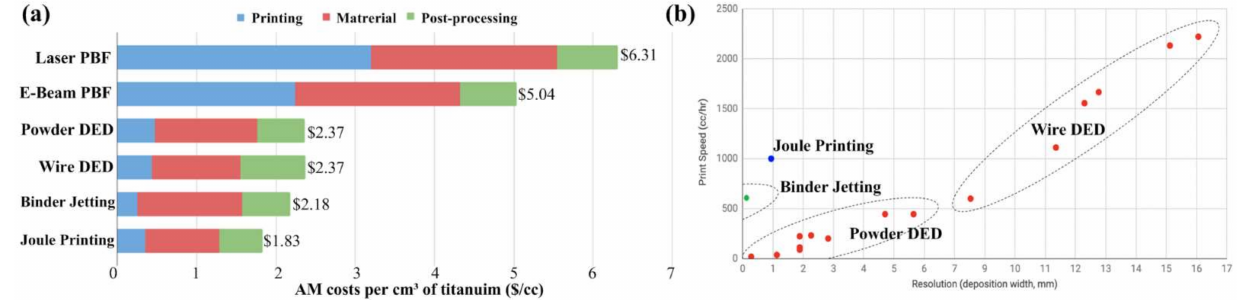
Figure 6. Comparison between cost efficiency, print speeds, and resolution [20]: ( a ) AM costs per cm 3 of titanium; ( b ) Print speeds vs.